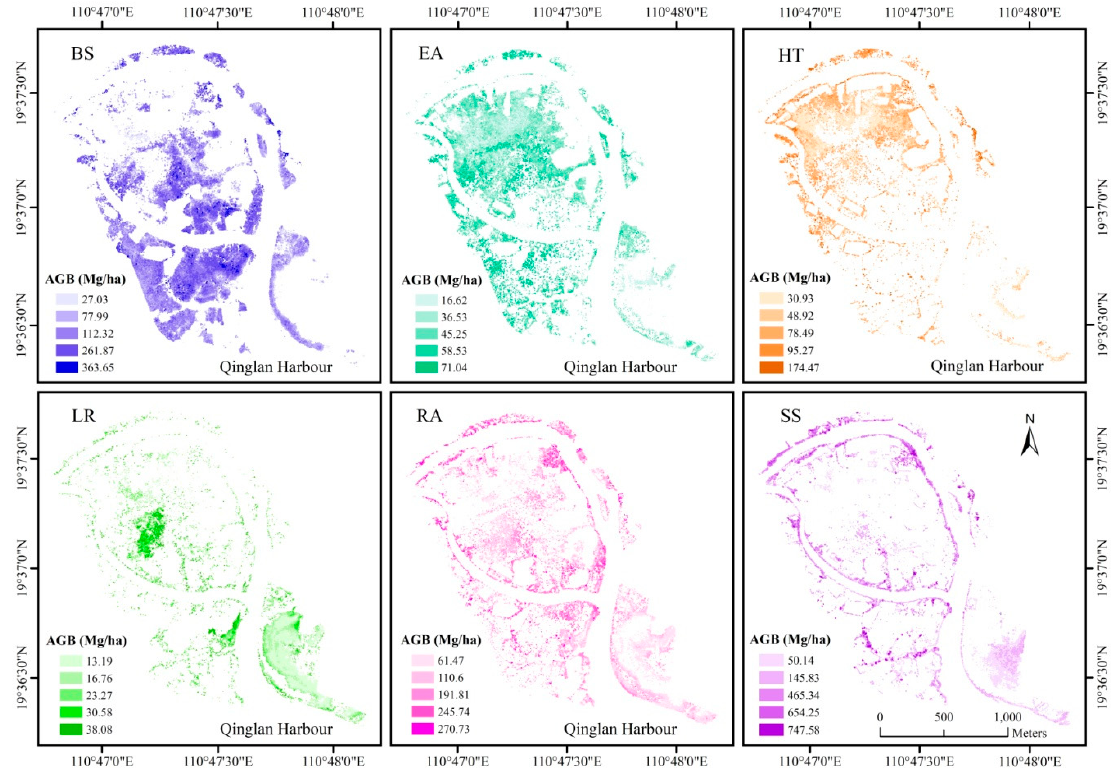
Figure 7. AGB distribution maps in different mangrove species determined from the individual tree-based inference method. BS: B. sexangula ; EA: E. agallocha ; HT: H. tiliaceus ; LR: L. racemosa ; RA: R. apiculata ; SS: Sonneratia spp.